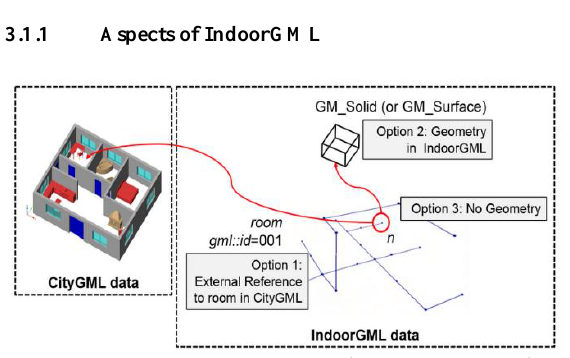
Figure 8. IndoorGML core model (Jiyeong Lee, 2018a)